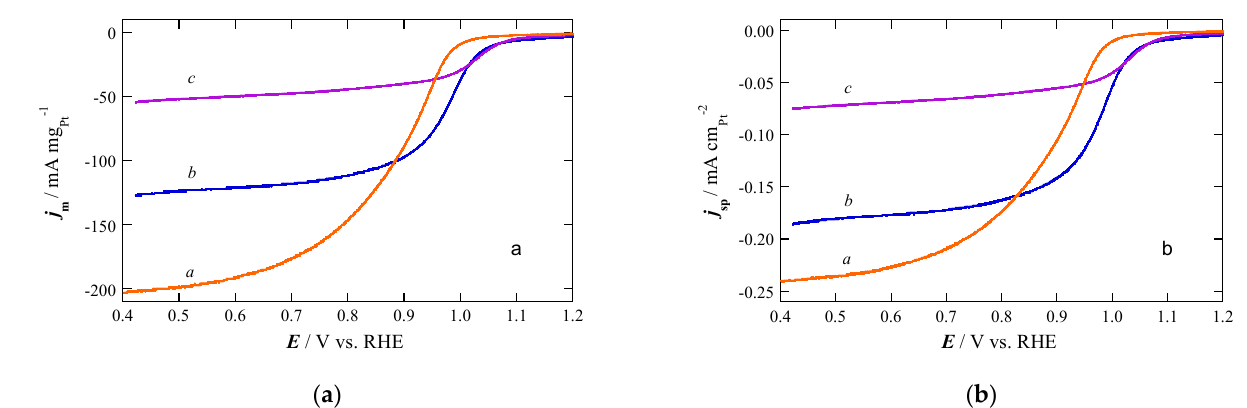
Figure 6. Linear sweep voltammograms for the ORR in O 2 -saturated 0.5 mol dm − 3 H 2 SO 4 solution at 5 mV s − 1 and an RDE rotation rate of 1500 rpm. ( a ) Current per mass ( j m ) and ( b ) specific current ( j sp ) vs. potential. In both plots, the catalysts are: Pt/C ( a ), Pt(Cu)/CMK3 ( b ), and Pt(Cu)/CMK8 ( c ).